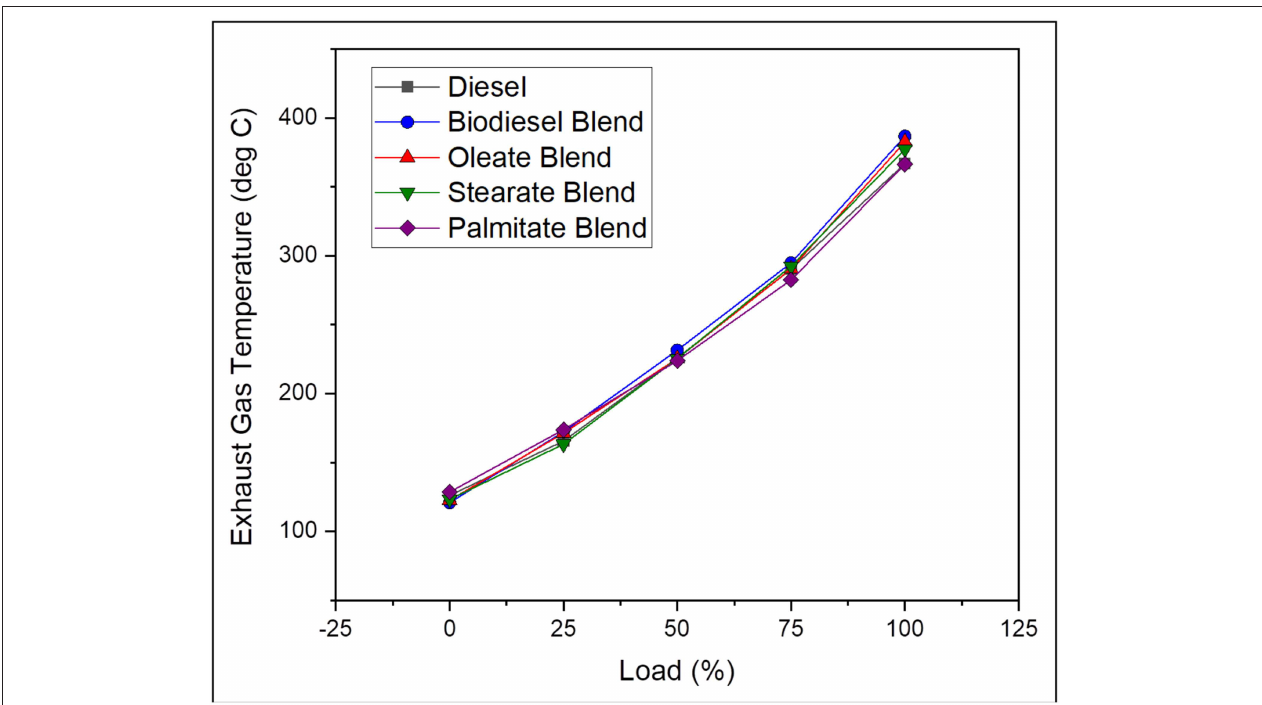
FIGURE 4 | Exhaust gas temperature of diesel and blend samples for varying load conditions.